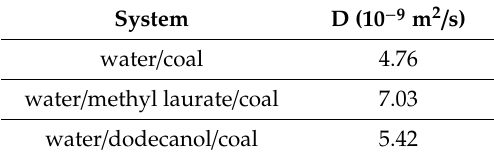
Table 8. The self-diffusion coefficient (D) of water in the water/coal and water/collector/coal system.